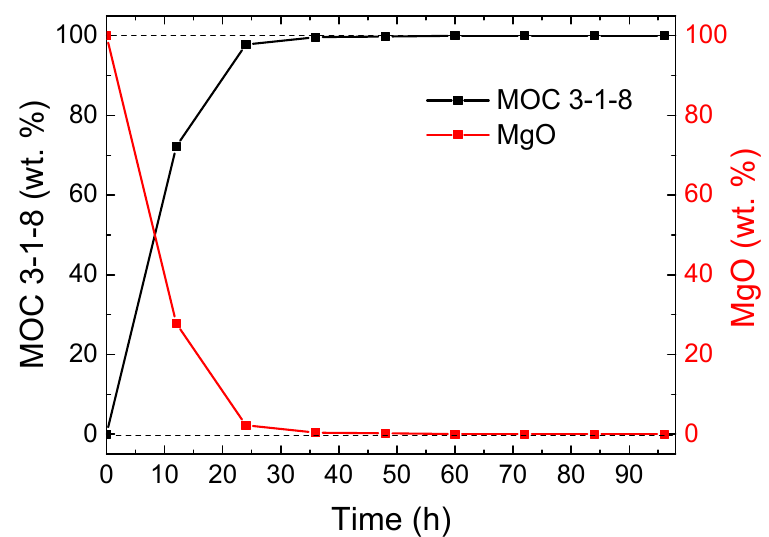
Figure 3. Sample composition obtained by Rietveld analysis.